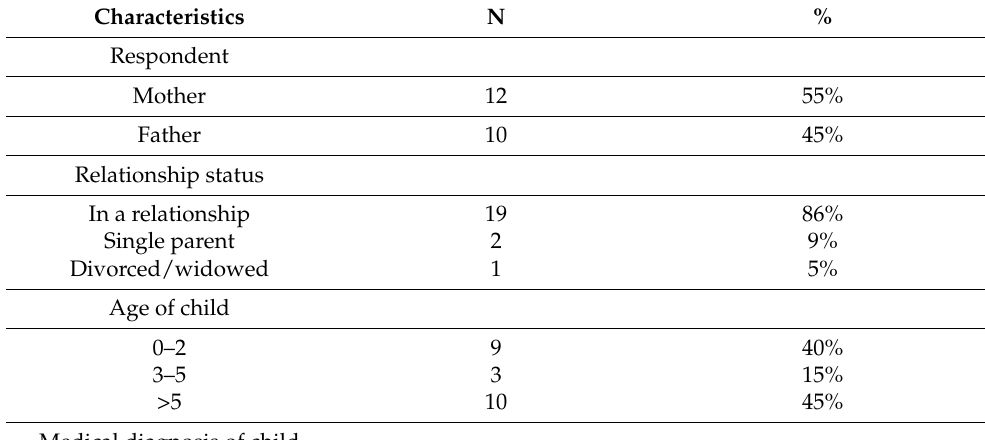
Table 1. Descriptive characteristics of the sample (N =